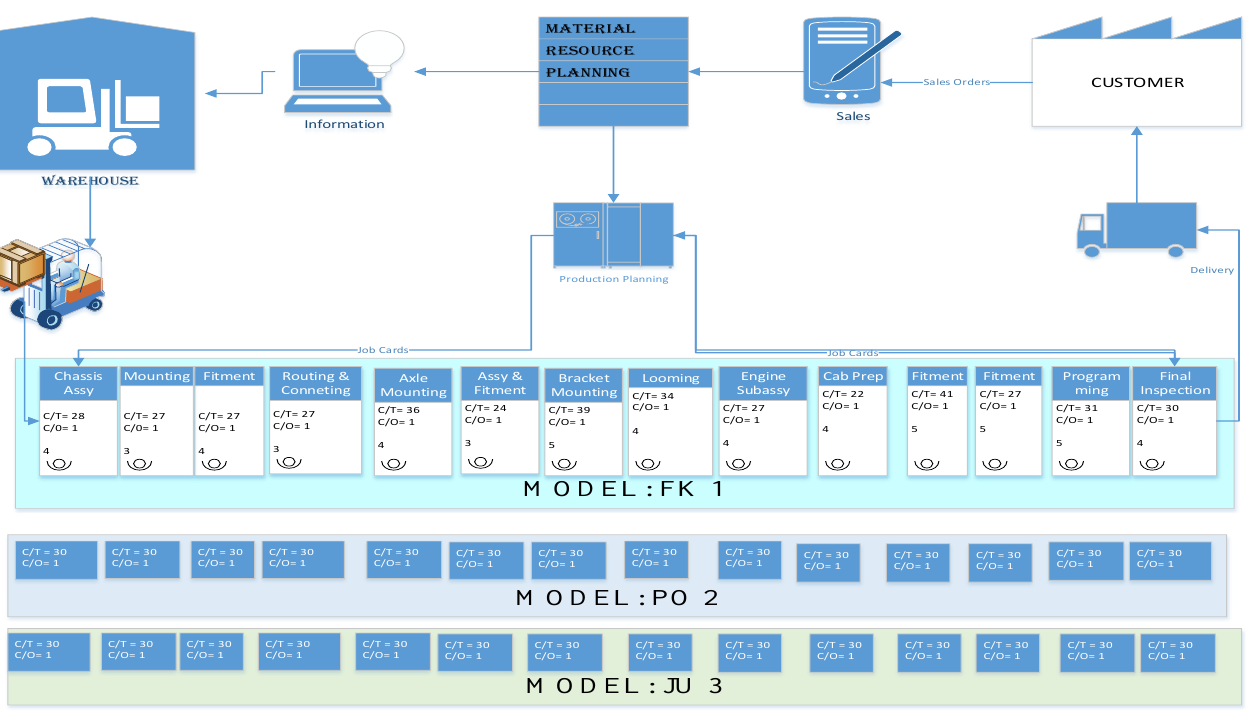
Figure 4. VSM modelling of the future state for the truck manufacturing industry (FK1, PO2 and JU3 are named after the workstations; C/T is cycle times and C/O operations times).